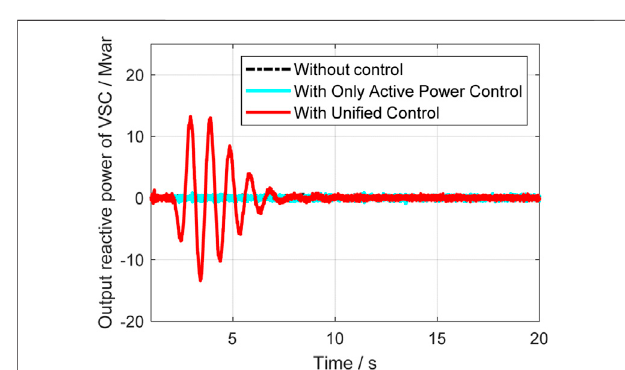
FIGURE 15 | Rotor speeds of G6 with different schemes.